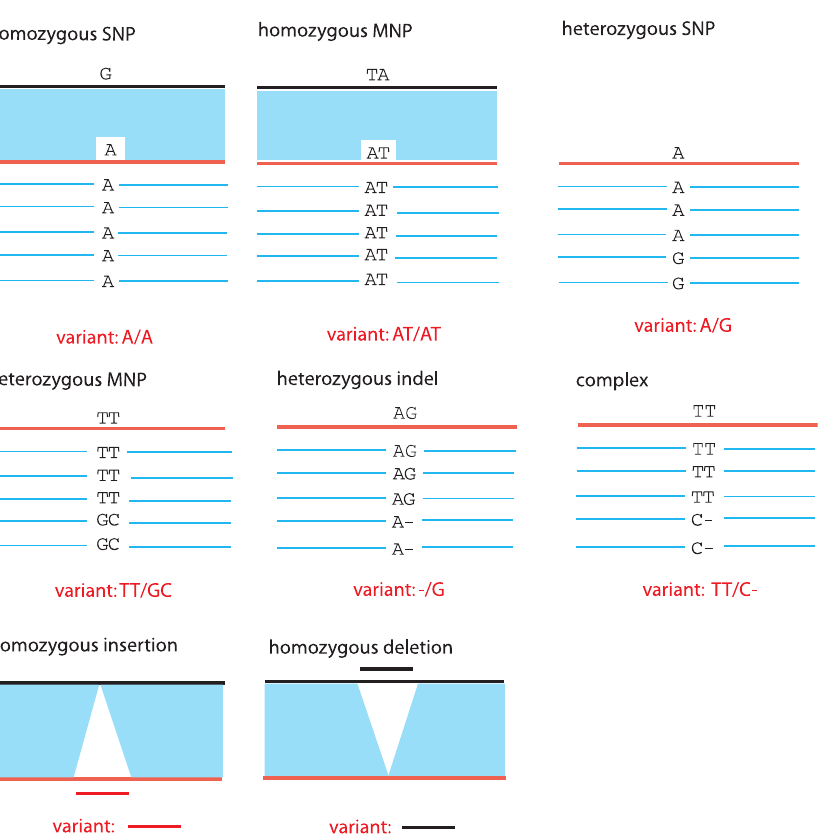
Figure 4. The Different Variant Types Identified from the HuRef Assembly and the HuRef-NCBI Assembly-to-Assembly Mapping HuRef consensus sequence (in red) with underlying sequence reads (in blue). Homozygous variants are identified by comparing the HuRef assembly with NCBI reference assembly. Heterozygous variants are identified by base differences between sequence reads. SNP ¼ single nucleotide polymorphism; MNP ¼ multi-nucleotide polymorphism, which contains contiguous mismatches.